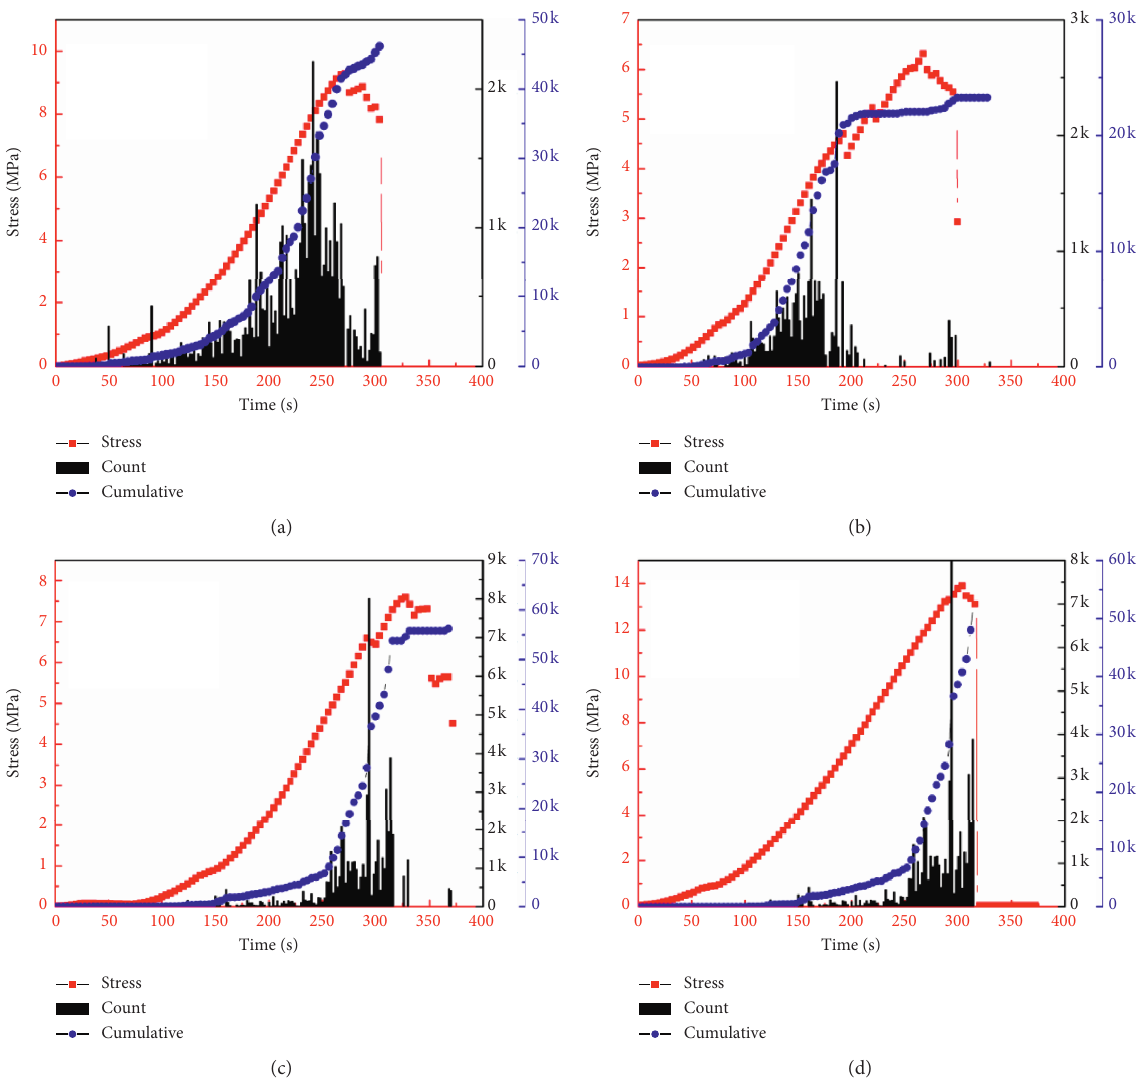
Figure 10: Relationship between AE ring count, stress, and time (“count” represents AE ring count and “cumulative” represents AE cumulative ring count). (a) Coal sample no. 0. (b) Coal sample no. 2. (c) Coal sample no. 4. (d) Coal sample no.